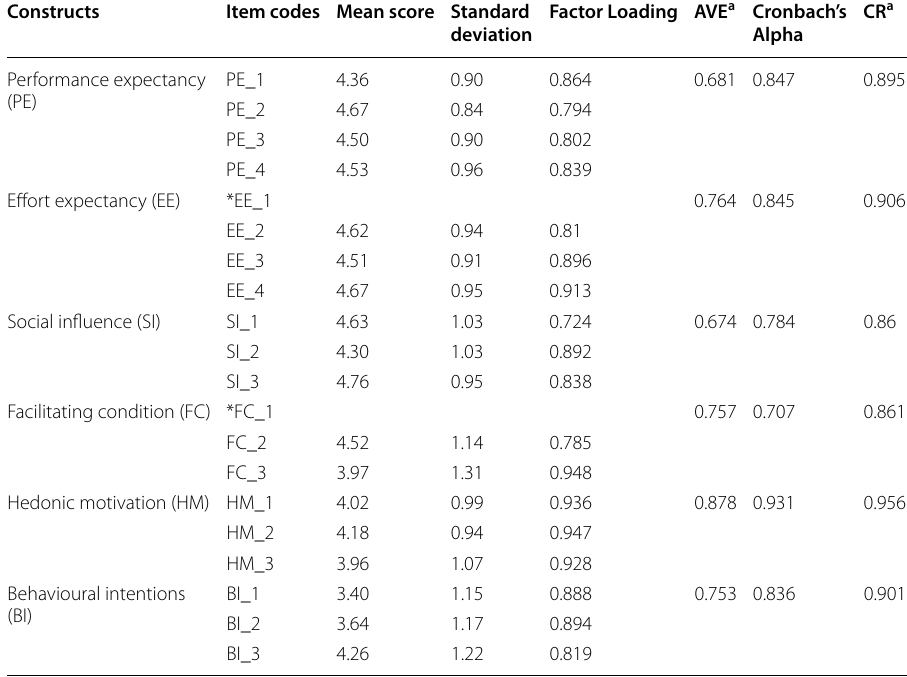
Table 2 Reliability and validity measures